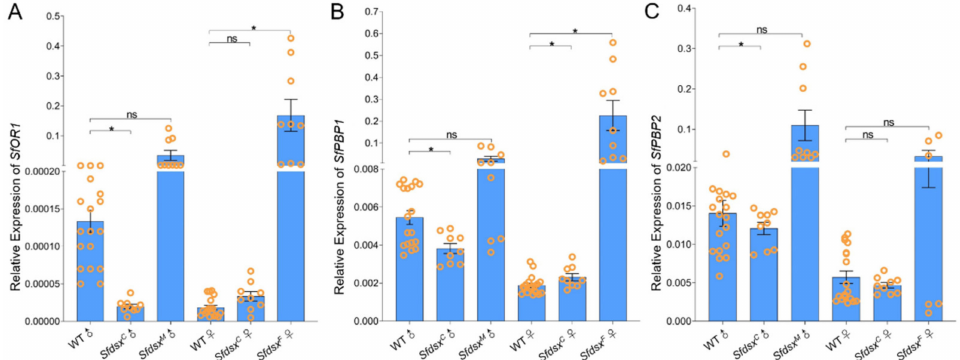
Figure 6. Relative expressions of OR1 , PBP1 , and PBP2 after Sfdsx C , Sfdsx F , and Sfdsx M mutagenesis. The relative transcript levels of OR1 ( A ), PBP1 ( B ), and PBP2 ( C ) were examined in WT male and female, Sfdsx C male, Sfdsx F female, and Sfdsx M males. ß-actin was the internal reference. The asterisks (*) indicate significant differences ( p < 0.05) between mutants and wildtypes. “ns” stands for “not significant” ( p > 0.05). Data were analyzed using a two-tailed t